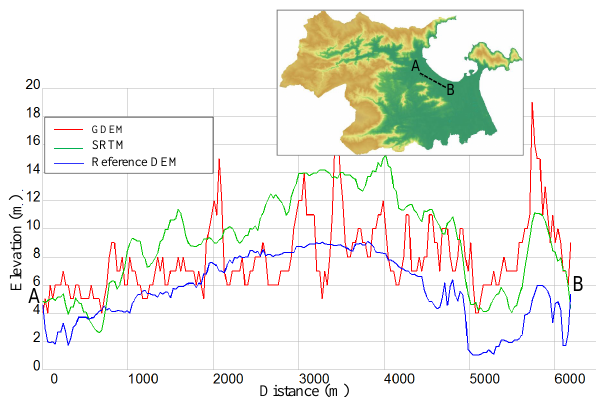
Figure 8. Difference elevation of GDEM and SRTM with respect to the reference DEM from mountain to flat